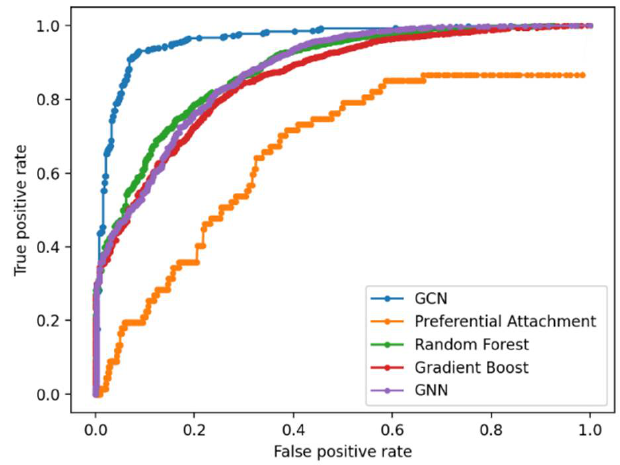
Figure 4. Receiver Operating Characteristic (ROC) curve showing true positive and false positive scores for link prediction in the GDKG using the five methods. Table 1. Ranking of genes and diseases with new predicted links using GCN.